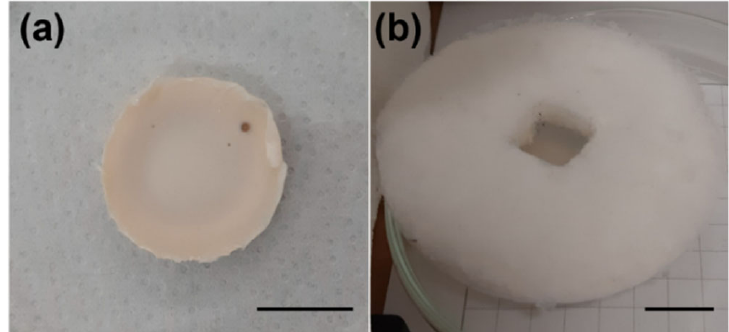
Figure 1. Macroscopic aspect of the prepared aerogels: ( a ) pectin ‐ based, ( b ) silica ‐ based. Physicochemical and textural properties of aerogels were assessed (Table 1). A very high volume shrinkage was observed for pectin-based aerogels in contrast to what was observed for silica-based aerogels. The volume shrinkage verified for pectin structures was much higher than what is typically described in the literature for similar structures (about 48 ± 28% [21]), unveiling poor textural properties of the structures herein prepared. These suspicions were also supported by the bulk density ( ρ bulk ) observed, which was about two times higher than what was reported before (<0.15 g · cm − 3 ) [14,20,21]. Neverthe- less, textural analysis of pectin-based structures showed high specific surface area ( A BET ) and reduced specific pore volume ( Vp ,BJH ) and pore diameter ( dp ,BJH ). In fact, the A BET observed was even slightly higher, and the pore diameter slightly smaller than what was previously published by others [21]. The volume and diameter of the pores herein reported were assessed by BJH approach, an analytical method widely used yet presenting some